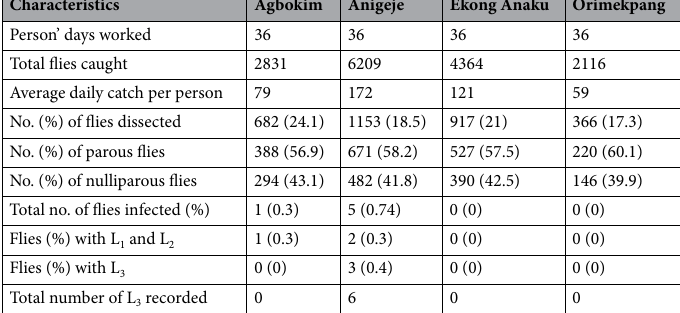
Table 5. Summary of transmission indices of S. damnosum in the four study